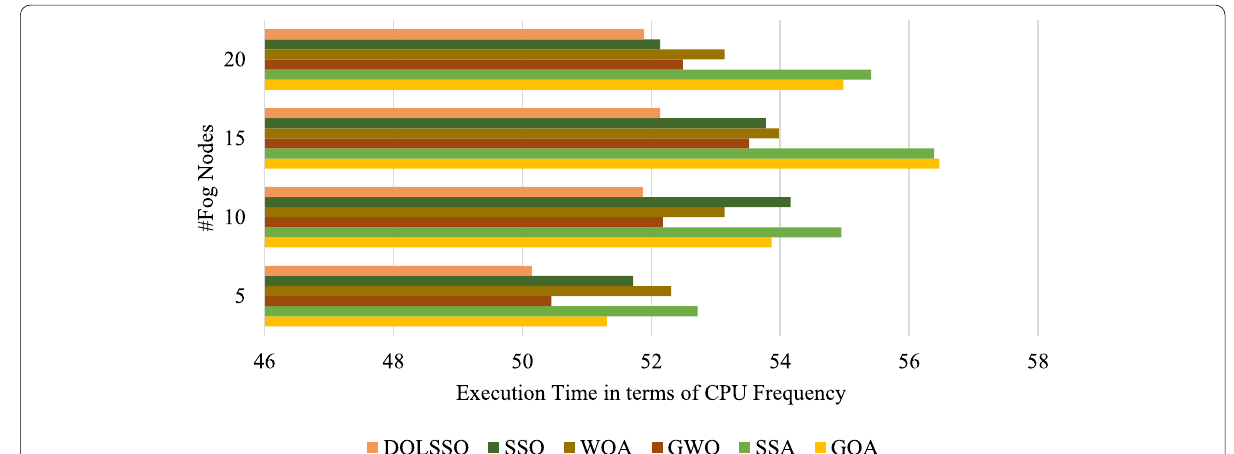
Fig. 5 Analysis and comparison of Execution time to process job